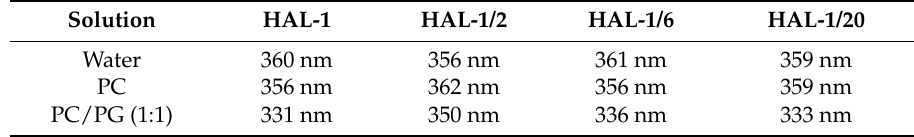
Table 2. Tryptophan fluorescence maxima of HAL-1 and its analogs (0.125 mg/mL—identical as for